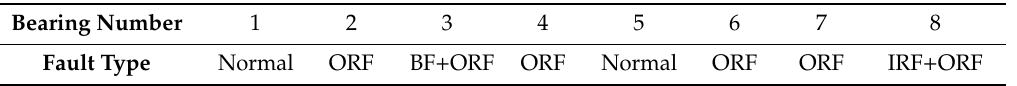
Table 10. Conditions of the axle-box bearings. IRF: inner race fault, ORF: outer race fault and BF: ball fault. Bearing Number